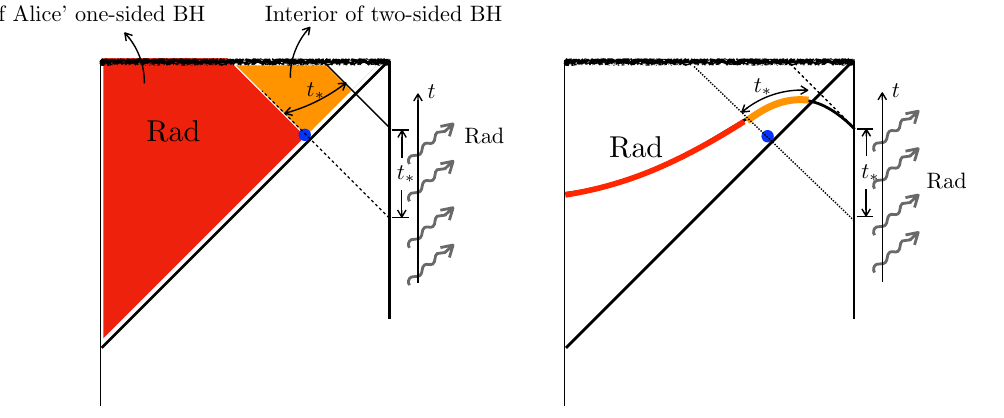
Figure 10 . A quantum circuit connecting the black hole and the radiation after Page time.